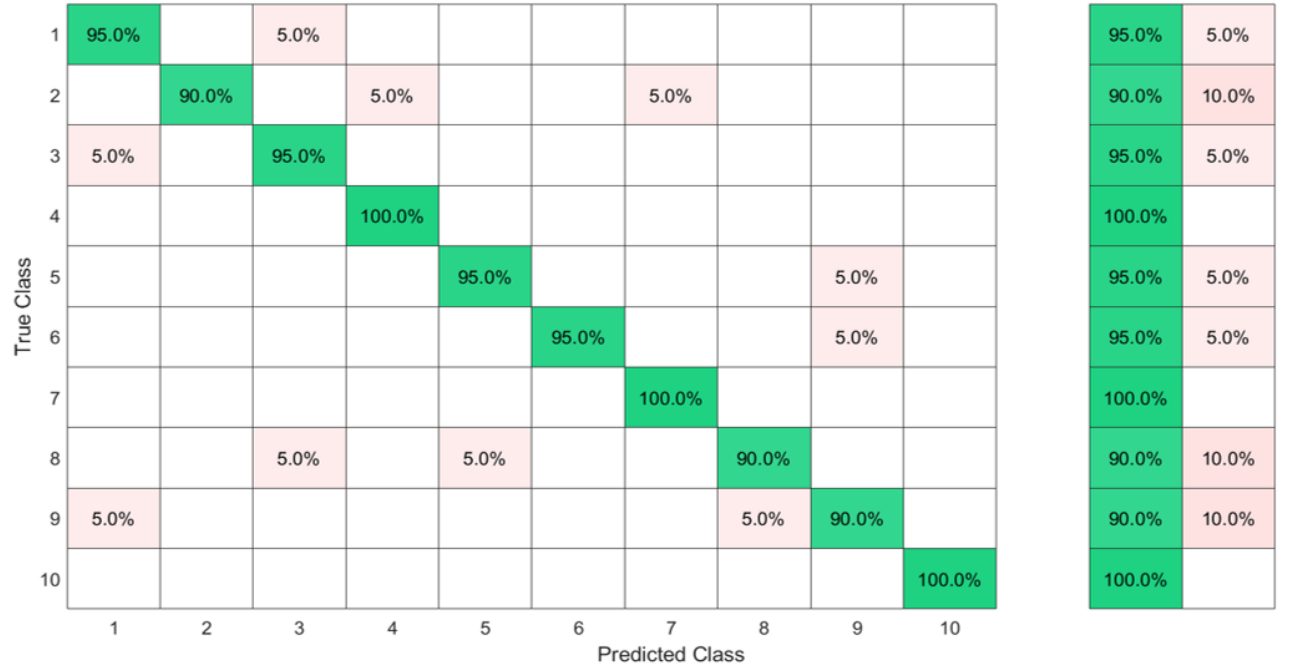
Figure 9. Ten ASL letters, A–J, detected with FMG and classified by the ELM after feature selection by the